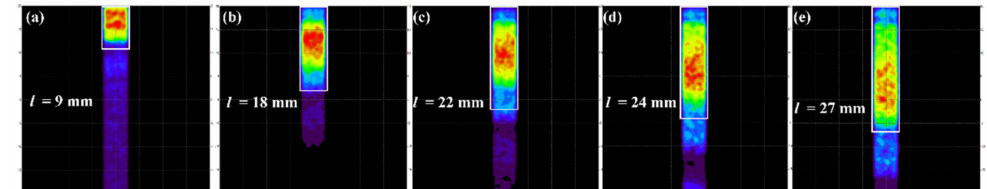
Figure 8. Incident solar power distributions along the axial direction of laser rods for the different systems (red area indicates the higher incident light intensity and the purple areas indicate lower incident light intensity.): ( a ) System 1; ( b ) System 2; ( c ) System 3; ( d ) System 4; ( e ) System 5. The optimized length of rod l is shown in each panel. Table 3. Lengths and reductions in the absorbed solar power and resonator losses (compared with a 40-mm-long Nd:YAG rod) for the laser rods of the different systems investigated. System No.